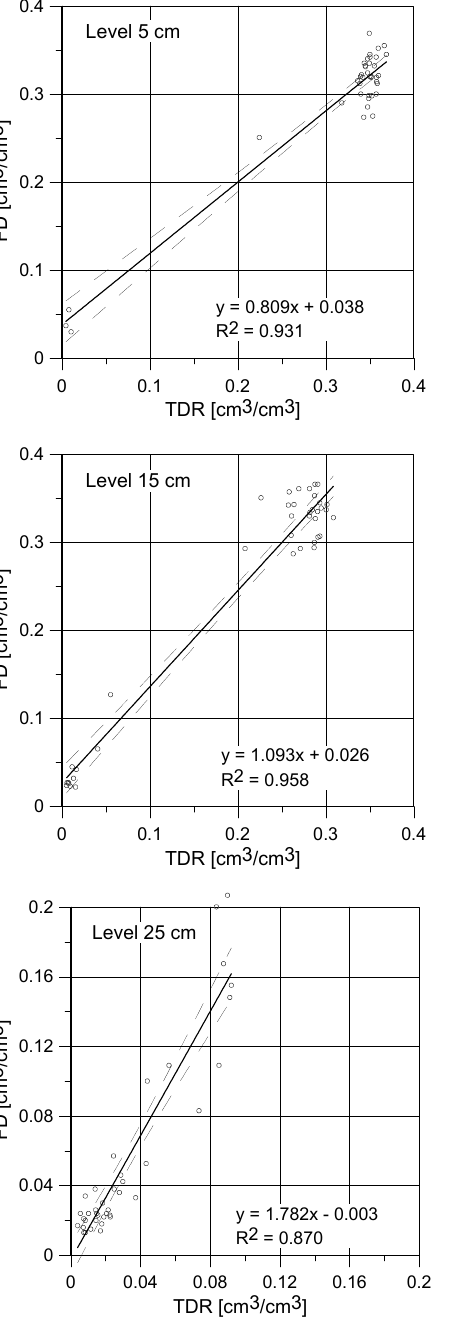
Figure 10. Comparison of capillary rise measurements results obtained by surface TDR sensor and FD capacitive sensor for aerated autoclaved concrete.